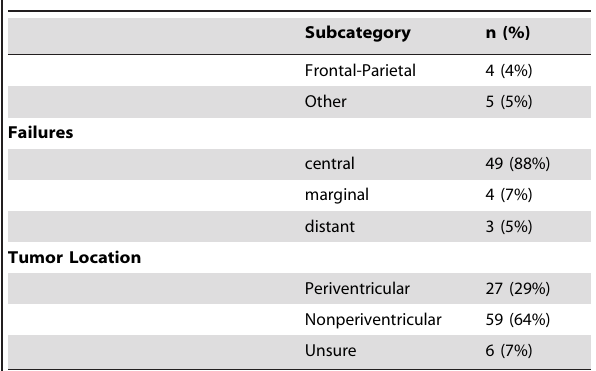
demographics, treatment details, and characteristics of primary tumor before surgery/chemoirradiation.